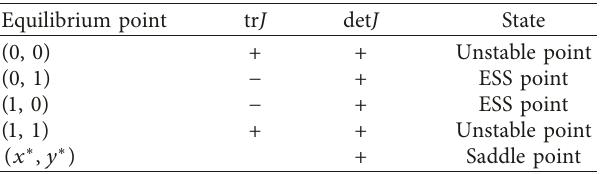
Table 6: Evolutionary stability of local equilibrium points in Scenario V.